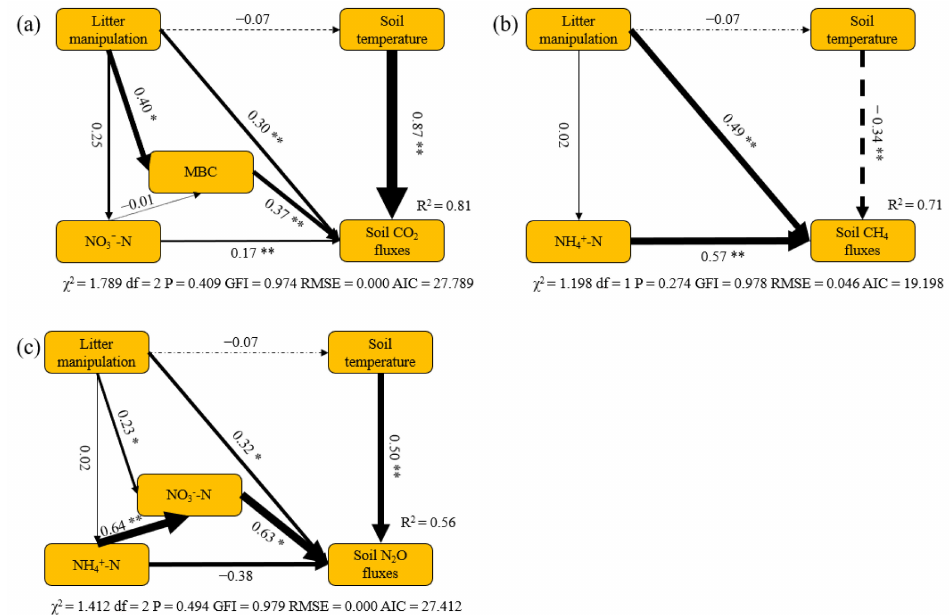
Figure 5. Structural equation models (SEM) show the major pathways of litter manipulation treat- ments on variations in soil CO 2 ( a ), CH 4 ( b ) and N 2 O ( c )fluxes in larch forest. Single arrows represent direct linear causal relationships. Numbers beside arrows are standardized path coefficients. Signifi- cance of the correlation is indicated at the 0.01 (**) and 0.05 (*) level. Arrow width is proportional to the size of the standardized path coefficients. Solid and dotted arrows indicate positive and negative relationships, respectively. R 2 denotes the proportion of variance explained by